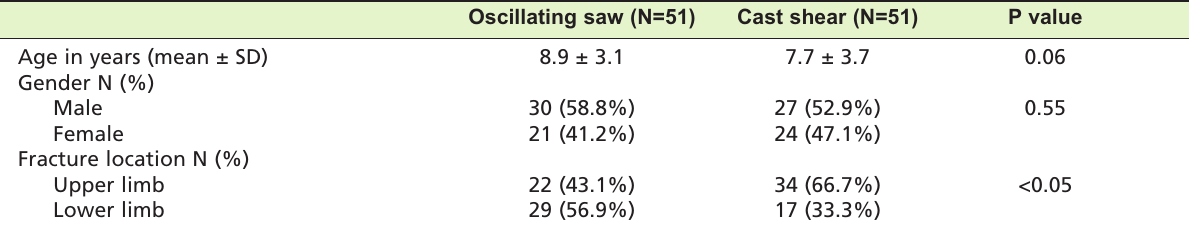
The characteristics of the study participants. Age is expressed as mean ± standard deviation while gender and fracture Table I: location are presented as total number (percentage)